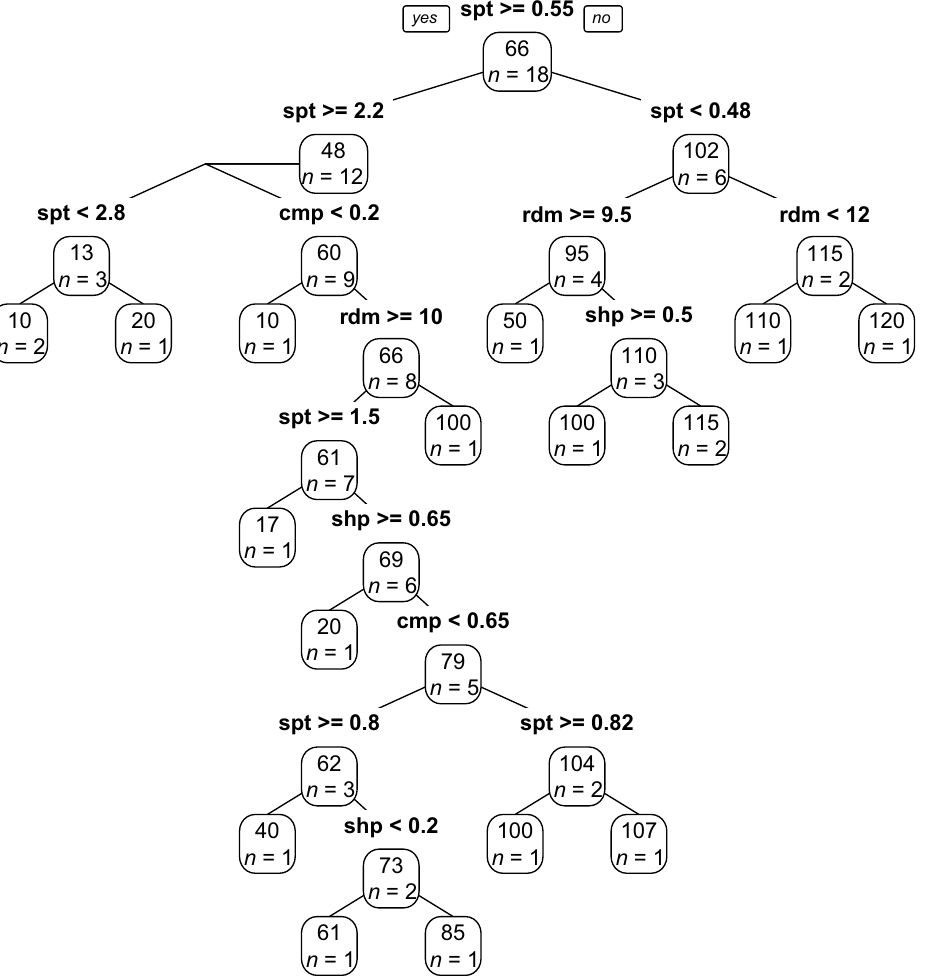
Figure A6. Graphical representation of the rulesets of the RT model established for the bare soil class. Note: spt = spatial resolution, rdm = radiometric resolution, shp = shape/color weight, and cmp = compactness/smoothness weight, n = the number of samples at each node; the values in the rectangles are the estimated SPs.